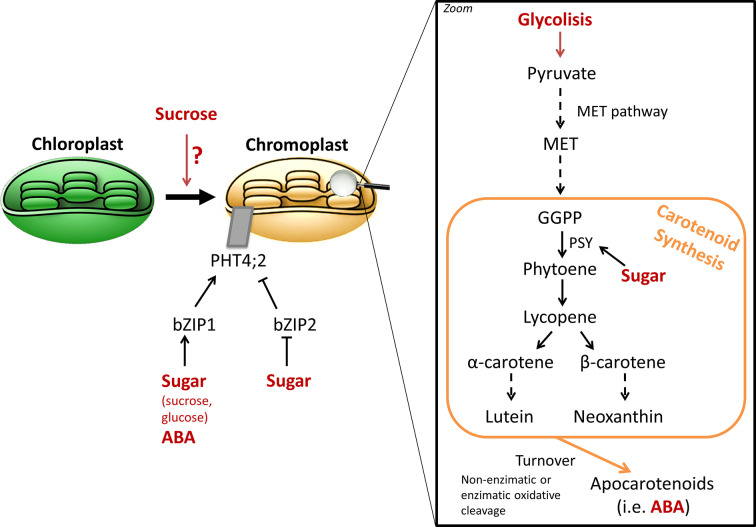
General schema of sugar signaling in carotenoid synthesis. Several evidences highlight the relationship between sugar content and carotenogenesis (Zhang et al., 2017; Heng et al., 2019). While sucrose appears to be involved chromoplast differentiation (Iglesias et al., 2001; Fanciullino et al., 2014), the molecular cascade remains unknown. Modulation of ClPHT4;2 expression through bZIP TF, which in turn are regulated by sugars and ABA, has been described to be involved in carotenoid accumulation during domesticated watermelon ripening (Zhang et al., 2017). While sugar catabolism can fuel carotenoid biosynthetic pathway by providing precursor building blocks through glycolysis, a regulating role over the pathway seems to exist, as demonstrated by the effect upon phytoene synthase (PSY) expression (Télef et al., 2006). In addition, sugar effect on carotenoid synthesis may also impact its crosstalk with ABA, as carotenoid turnover yields apocarotenoids, which serve as ABA precursors.